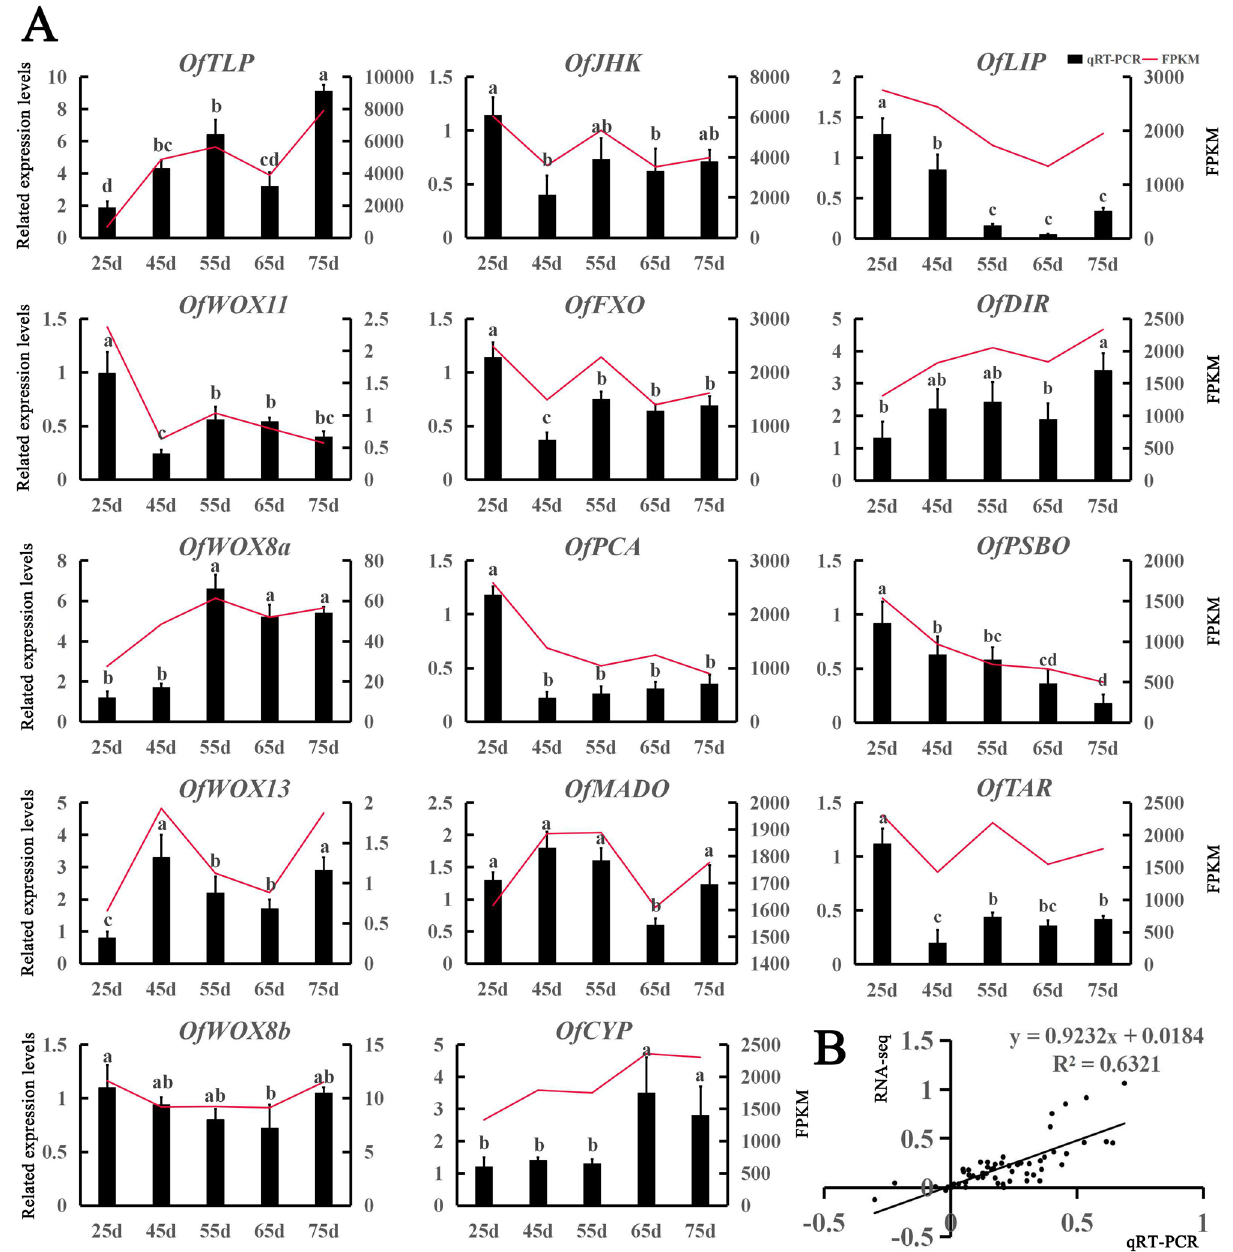
Figure 4. qRT-PCR validation of the transcriptome data results for 14 selected genes. ( A ) Expression levels of 14 genes and FPKM values. Different letters denote significant differences according to the Tukey’s test ( P < 0.05). ( B ) Correlation analysis of the gene expression ratios between qRT-PCR and